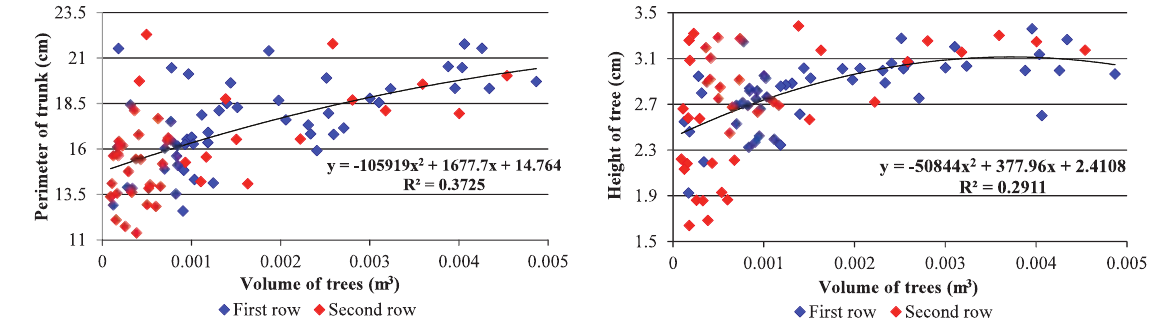
Figure 2. Correlation between trees volume and the investigated structural parameters